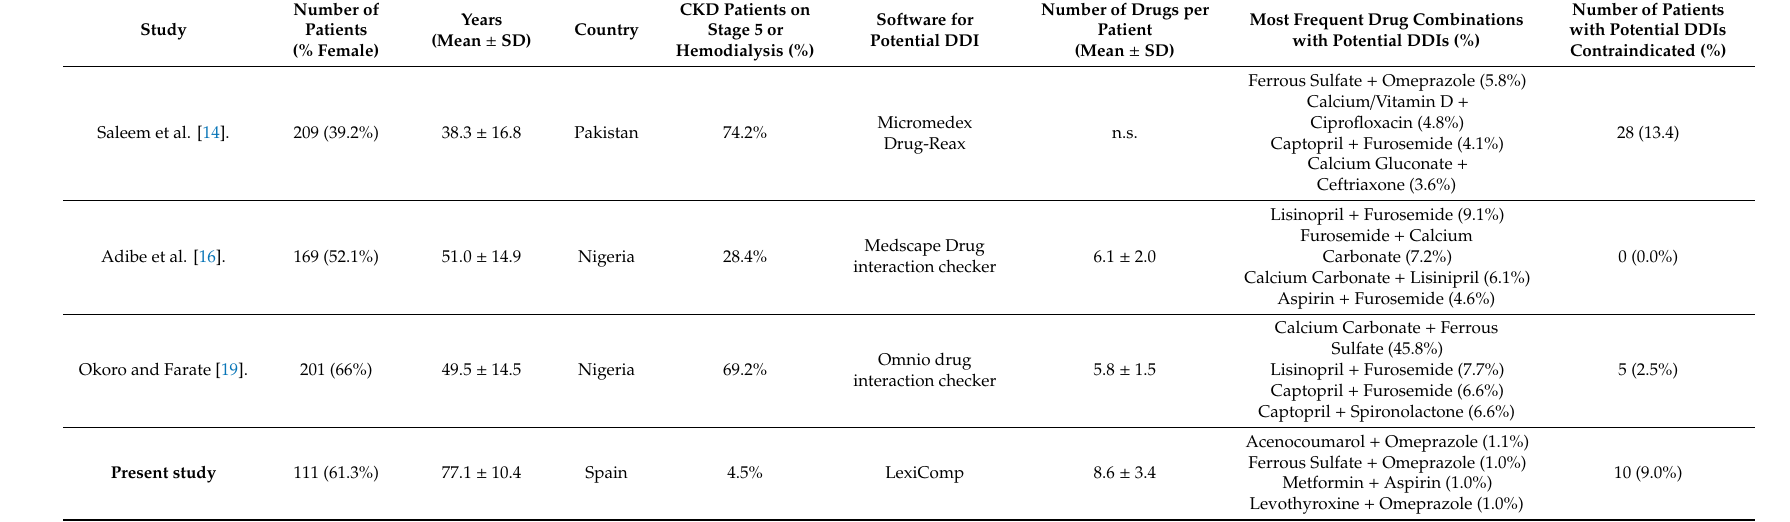
Table 8. Previous studies in which prevalence and severity of potential drug–drug interactions has been evaluated on CKD patients. Number of CKD Patients on Number of Drugs per Years Software for Most Frequent Drug Combinations Study Patients Country Stage 5 or Patient (Mean ± SD) Potential DDI with Potential DDIs (%) (% Female) Hemodialysis (%) (Mean ± SD)